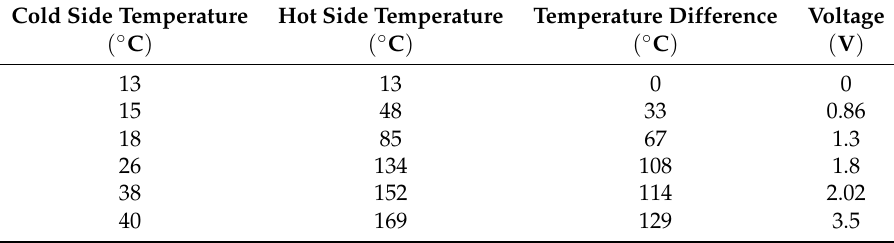
Dependence of the voltage on temperature difference in Peltier cells for the third experimental